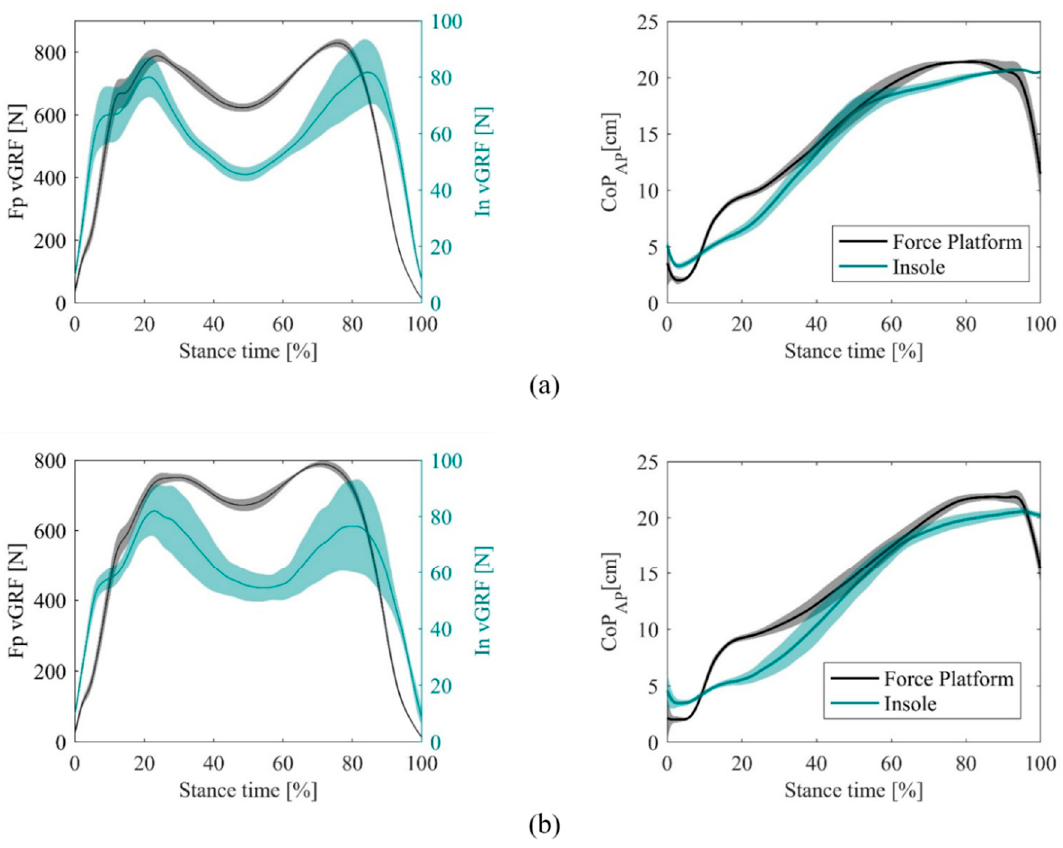
Figure 5. Average (right) vGRF and CoP AP stance curves measured by the force platform (black) and insole (green) for one participant during the self-selected ( a ) and slow ( b ) speed trials. Table 2. Median (iqr) values for the vertical Ground-Reaction Force (vGRF) parameters. Insole Force